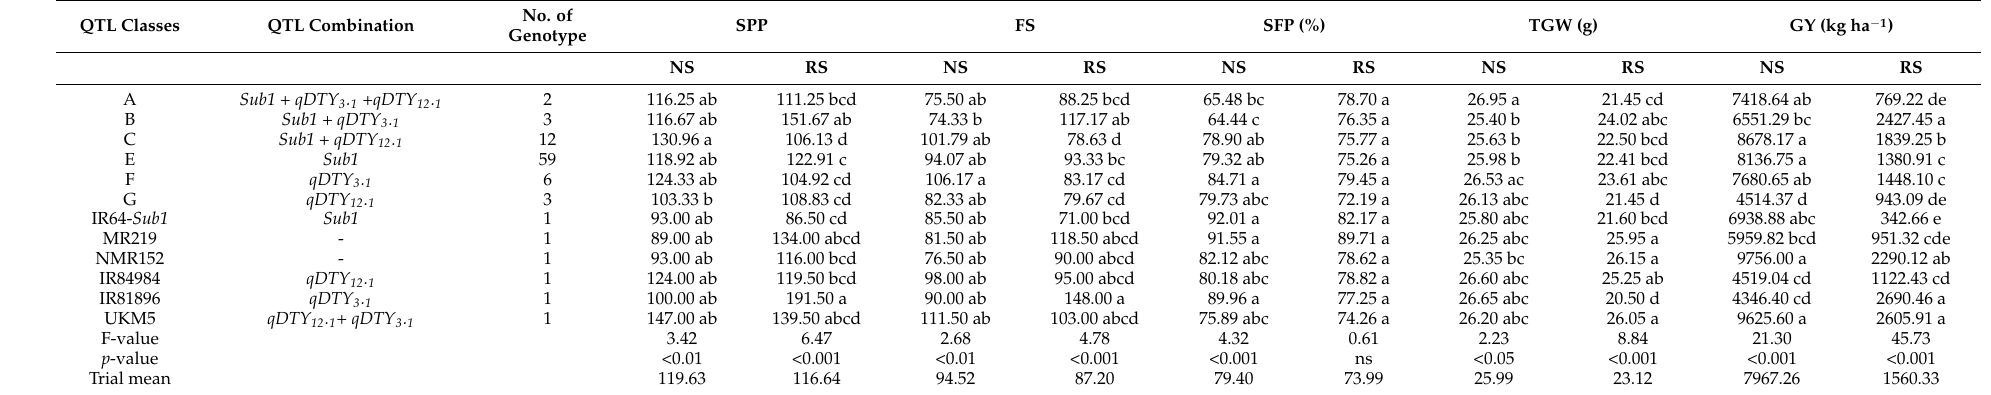
Table 3. Mean of quantitative trait loci (QTL) classes and checks for traits number of spikelet per panicle (SPP), number of filled spikelet per panicle (FS), spikelet fertility percentage (SFP), thousand-grain weight (TGW) and grain yield (GY) evaluated in non-stress (NS) and reproductive stage drought stress (RS)